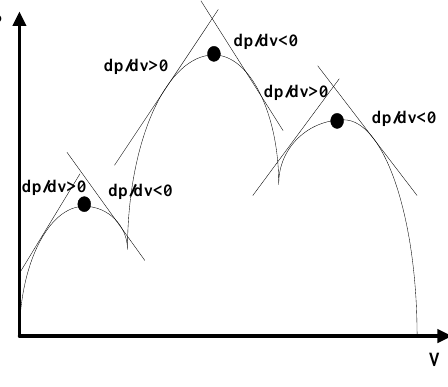
Figure 10. Change of dp/dv in both sides of